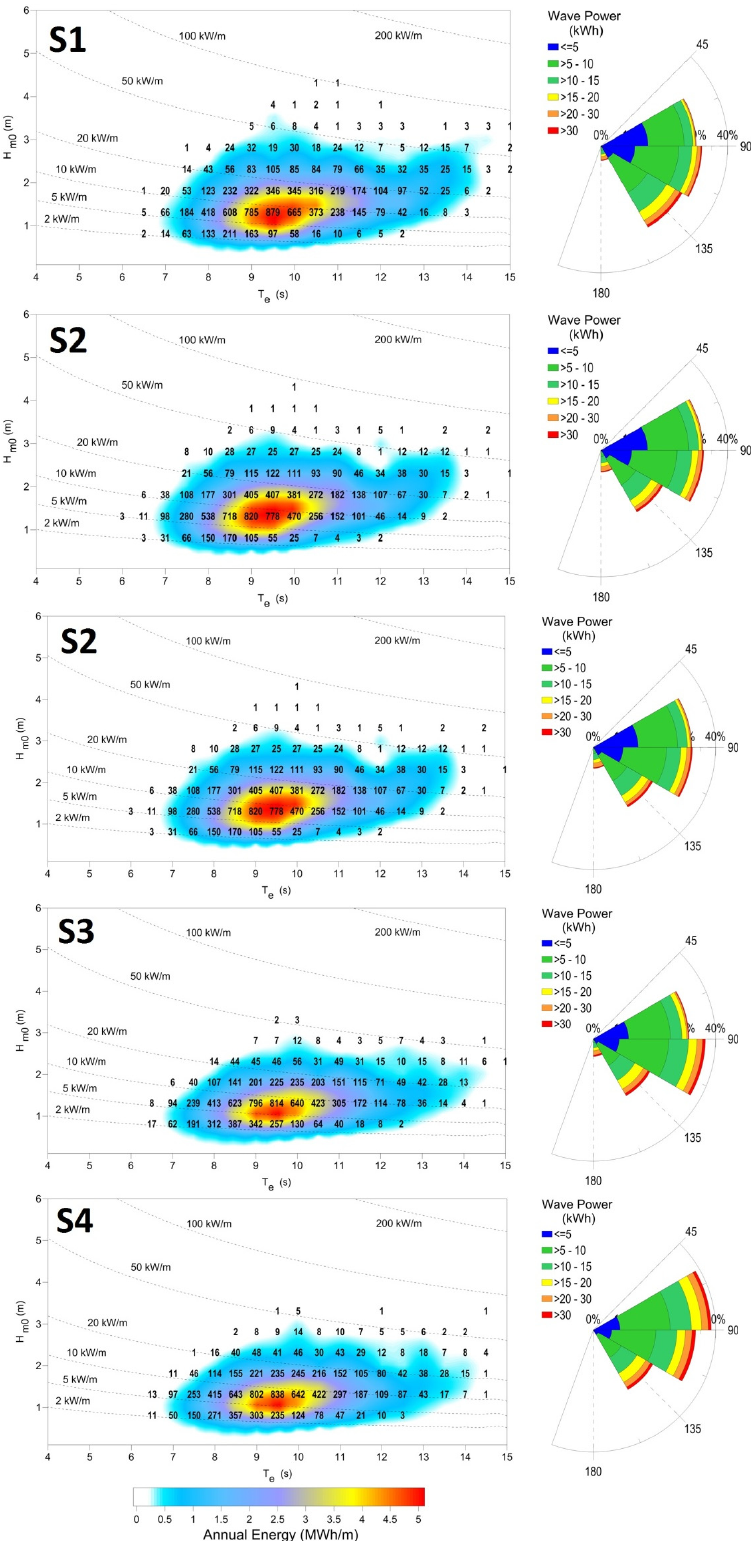
Figure 12. Characterization of the yearly average wave energy points S1, S2, S3, S4 in terms of significant wave height (H m0 ) and energy period (T e ). The color scale represents annual energy per meter of wave front (in MWh/m). The numbers within the graph indicate the occurrence of sea states (in number of hours per year) and the isolines refer to wave power.